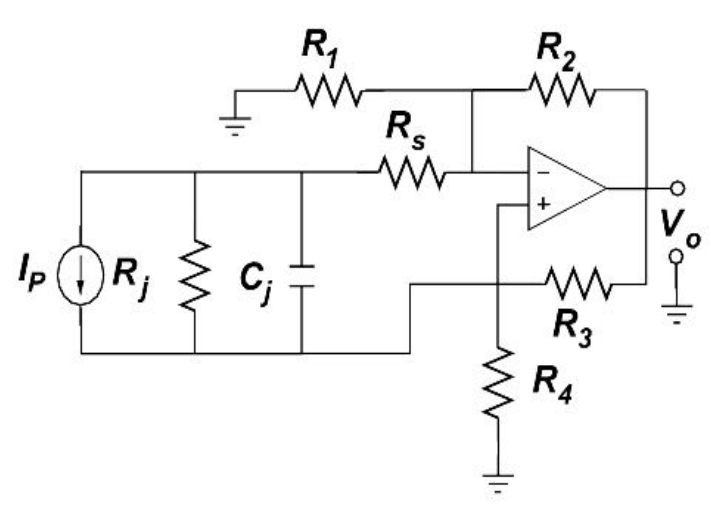
Figure 1. Robust photometer